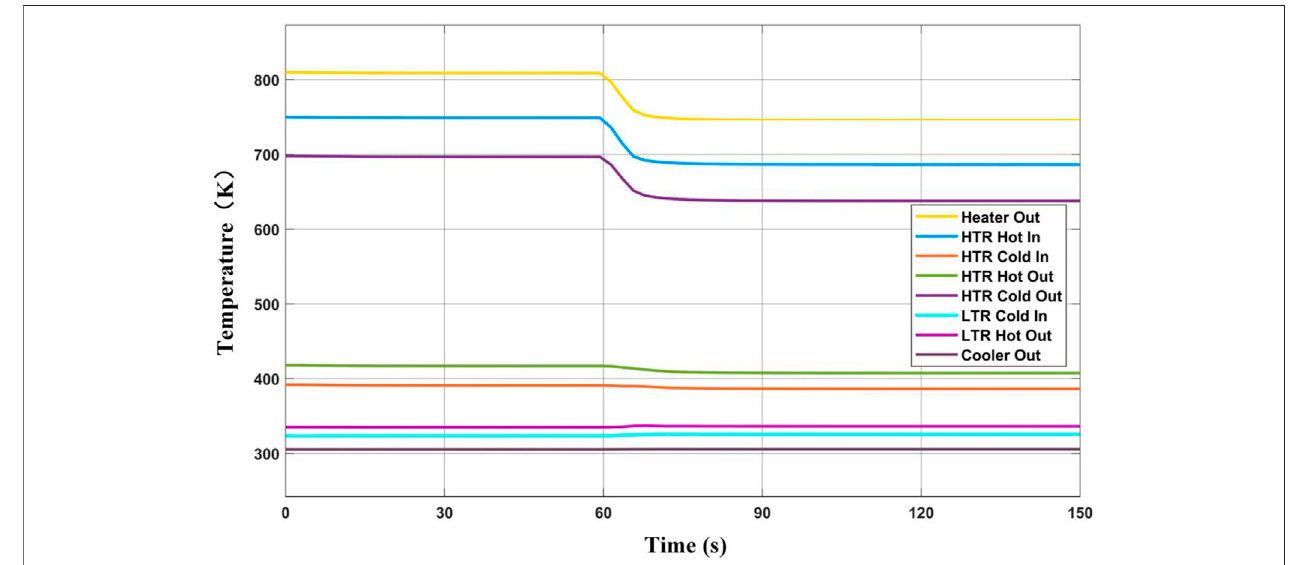
FIGURE 13 | Dynamic response of cycle temperature while increasing the cycle mass fl ow rate.